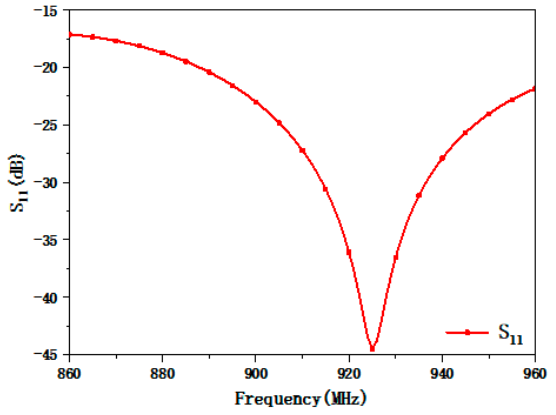
Figure 20. Simulated reflection coefficients S11 of the antenna unit.